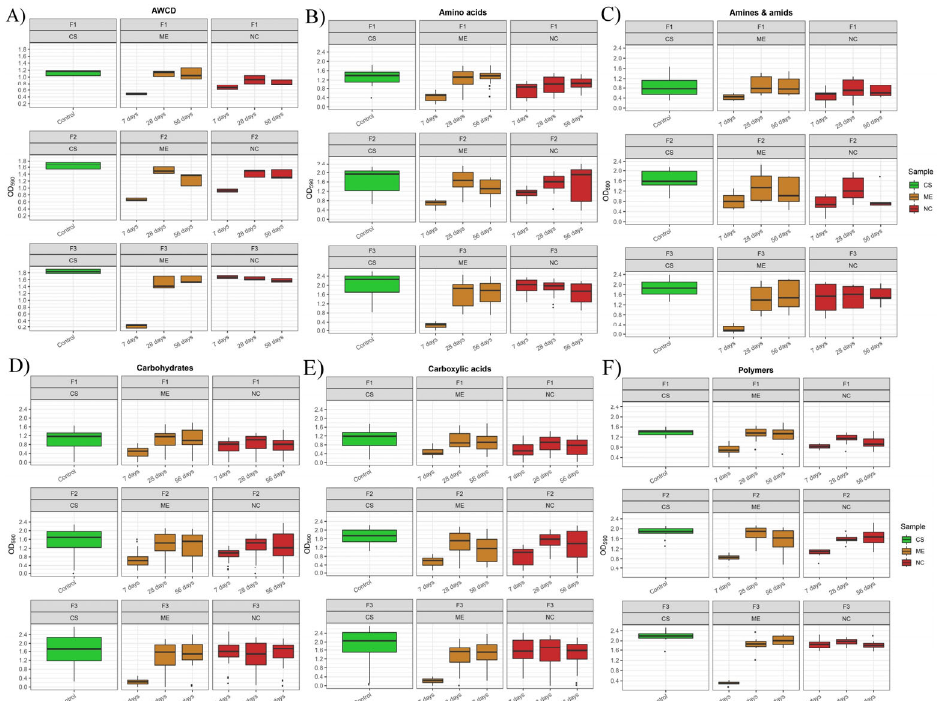
Figure 9. Change in the AWCD (average well colour development) and utilization of particular carbon substrate groups from EcoPlate™ by microorganisms during the model experiment and natural condition: ( A ) AWCD; ( B ) amino acids (n = 6); ( C ) amines and amides (n = 2); ( D ) carbohydrates (n = 10); ( E ) carboxylic acids (n = 9); ( F ) polymers (n = 4). Box plot: whiskers represent the minimum and maximum values, the horizontal line in the box indicates the median, points under the box indicate outliers. Explanation of the samples in Table 1.